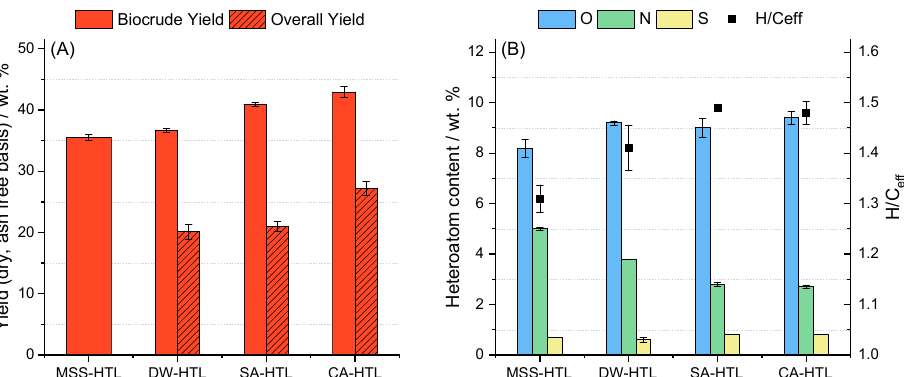
Figure 4. ( A ) Biocrude yield of hydrothermal liquefaction and the overall yield of the combined process with pre-treatment and ( B ) heteroatom content (O, N, S) and H/C eff of derived biocrude.